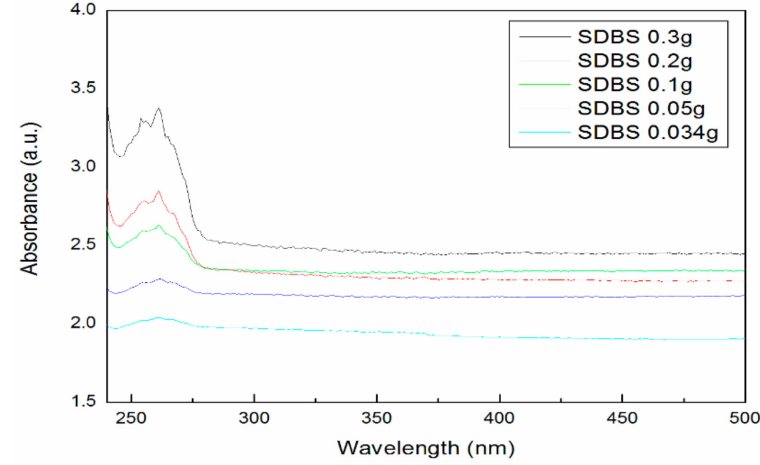
Figure 5. Absorbance of graphene by SDBS addition ratio.